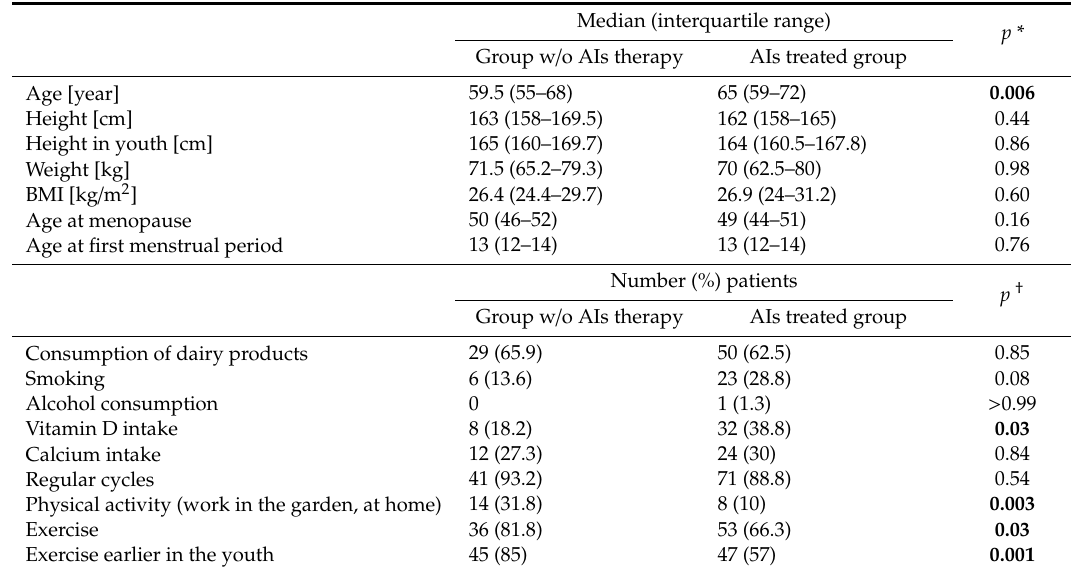
Table 2. Demographic patient characteristics.